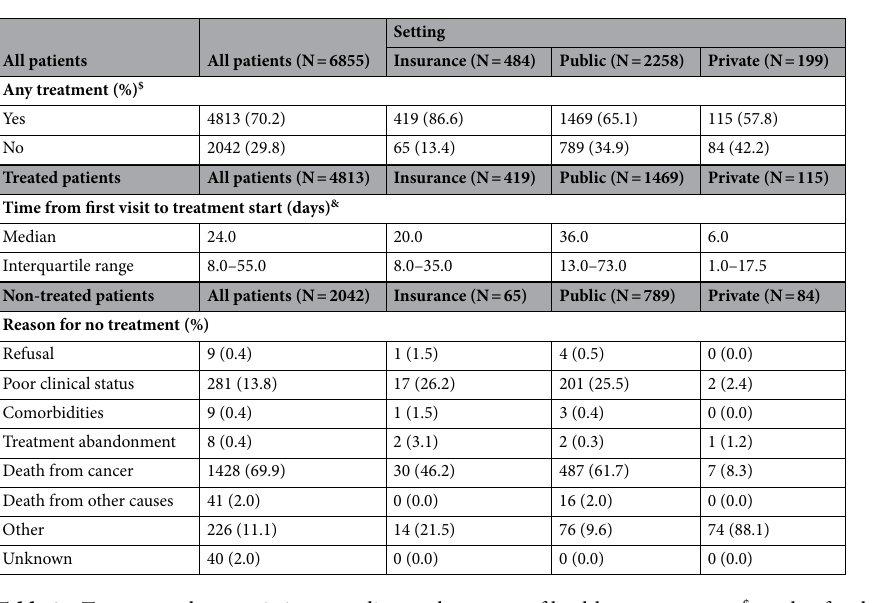
Table 3. Treatment characteristics according to the source of health care payment. $ p-value for the difference among Insurance, Public, and Private < 0.001 (Fisher exact test). & p-value for the difference among Insurance, Public, and Private < 0.001 (Kruskal–Wallis